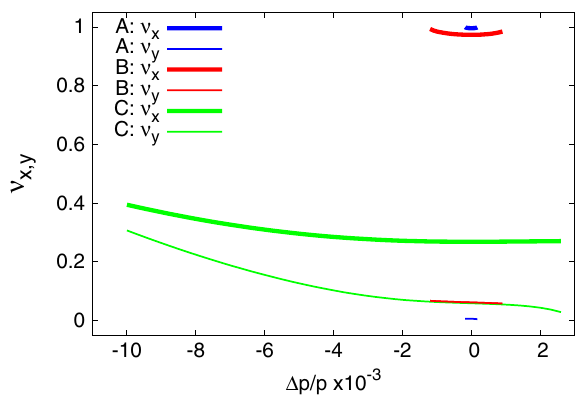
FIG. 19. Fractional betatron tunes (cid:3) x and (cid:3) y as a function of momentum offset (cid:1) p=p for points A, B, and C in Fig. 17, as indicated by the color.